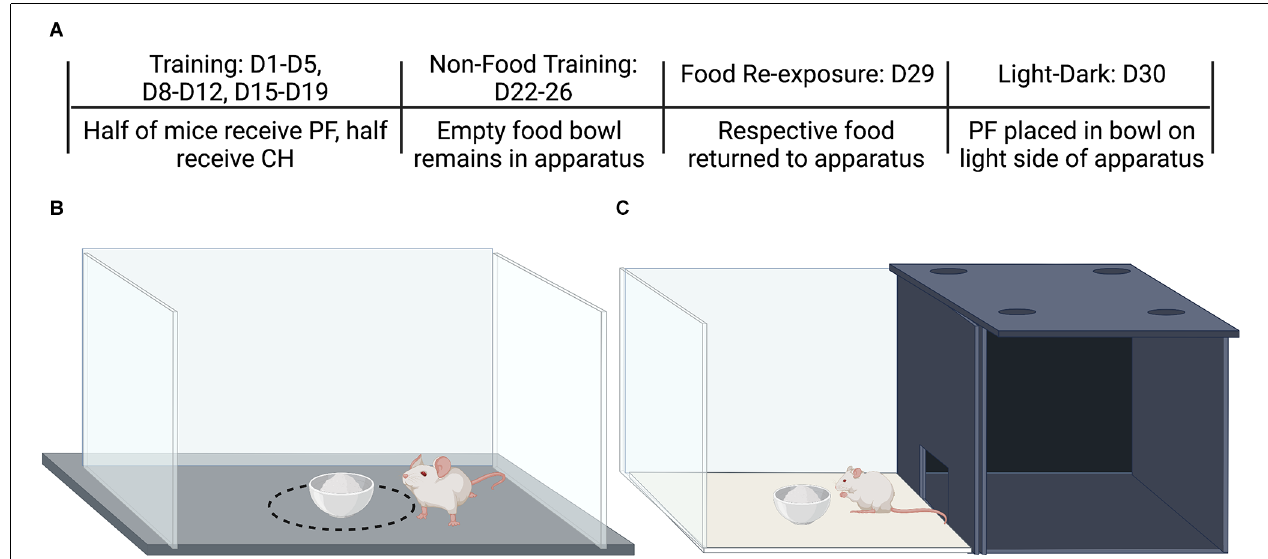
FIGURE 1 | Protocol for food intake training trials, no-food training, re-exposure of food availability, and the light-dark conflict test for compulsive-like food intake. (A) Testing schedule for assessing acute and escalated food intake. On training days (D1-D5; D8-D12; D15-D19), mice of each Substrain and Sex received either palatable food (PF) or Chow (CH) . During the no-food training period (D22-D26), the food bowl remained in the apparatus but no food was provided. On the day of re-exposure of food availability (D29), the food was returned to the apparatus. The day following re-exposure (D30), mice were placed on the dark side with open access to the light side which contained a food bowl filled with palatable food for all groups, including chow-trained groups. Cartoons were made using BioRender.com. (B) Apparatus used for training, no-food training, and re-exposure. The dashed black circle around the food bowl (14.4 cm in diameter) indicates the area used to estimate the “Circle time.” (C) Light-dark conflict testing apparatus. Figure made using